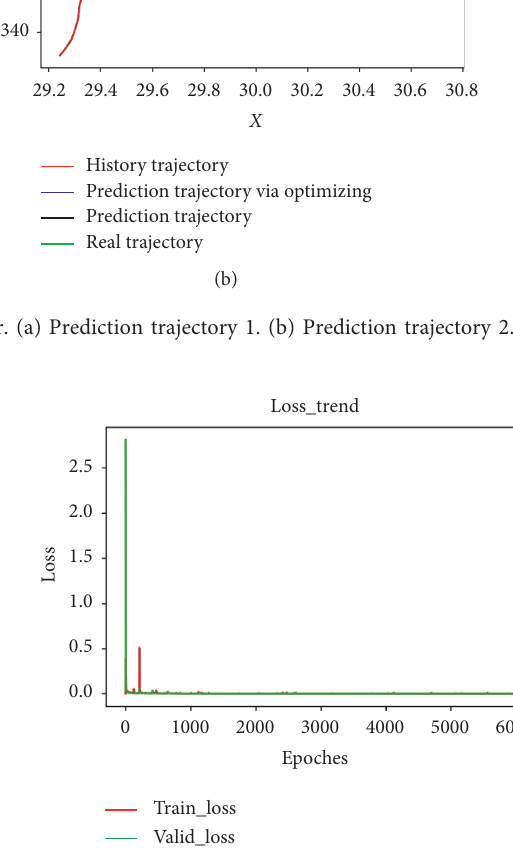
Figure 7: Training process of the trajectory prediction model considering